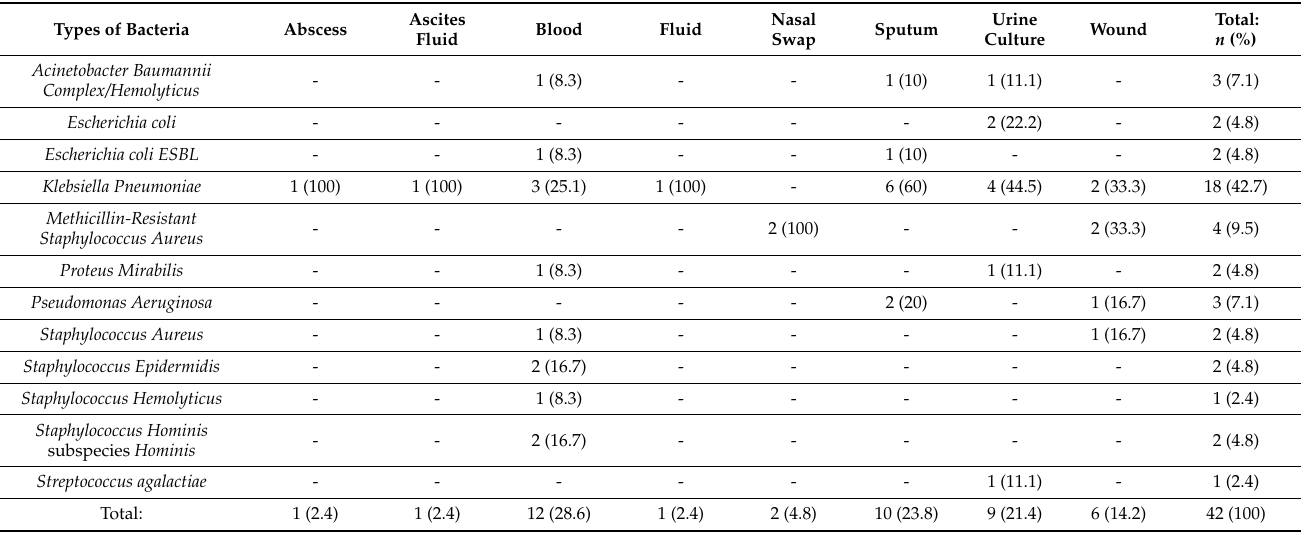
Table 3. Types of bacteria by the sources of the